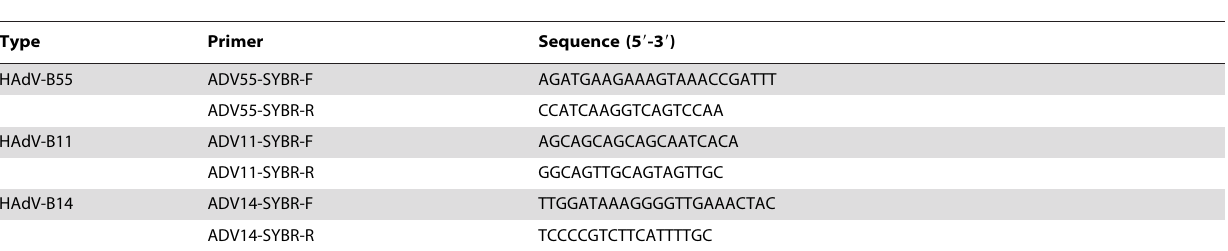
Table 1. Primers used in the real-time qPCR assay.